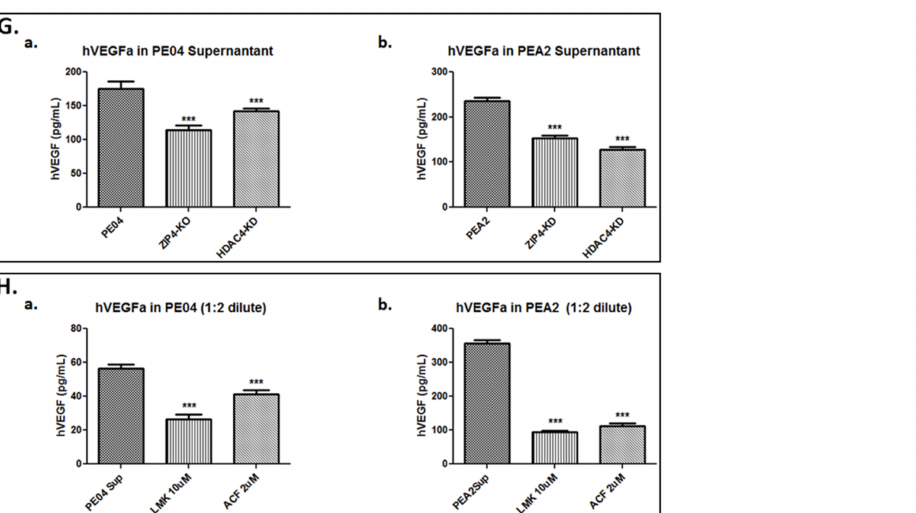
Figure 5. HIF1 α and VEGFA were involved in spheroid formation and in regulating VEGFA secretion. ( A , B ). Linifanib (Lin, a selective inhibitor of VEGFA, 3 µ M) and acriflavine (Acri, a selective inhibitor of HIF1 α , 0.5 µ M) inhibited cell proliferation and spheroid formation in PE04 cells. ( C ). Quantitative summary of the inhibitors’ effects from > three independent experiments. *** p < 0.001. ( D , E ). HIF1 α gene transfected green cells compensated for the spheroid formation activity lost in HDAC4-KD PE04 and PEA2 cells. Representative pictures are shown. The scale bars = 1000 nm. ( F , G ). VEGFA gene transfected green cells compensated for the spheroid formation activity lost in HDAC4-KD PE04 and PEA2 cells. The scale bars = 1000 nm. ( G ). ZIP4-KO/KD and HDAC4-KD in PE04 and PEA2 cells reduced the secreted levels of VEGFA. ( H ). LMK235 and Acri inhibited secreted VEGFA in PE04 and PEA2 cells. For quantification, cell aggregates < 100 nm and/or with irregular shapes were not counted as spheroids. For quantification, cell aggregates < 70 nm and/or with irregular shapes were not counted as spheroids. Representative pictures from three independent experiments are shown. ≥ *** p < 0.001.